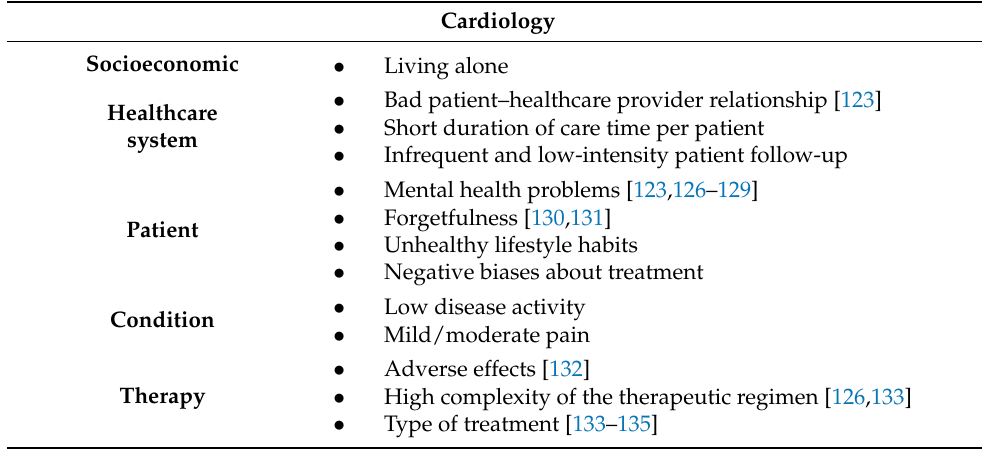
Table 3. Cardiology risk factors of non-adherence.